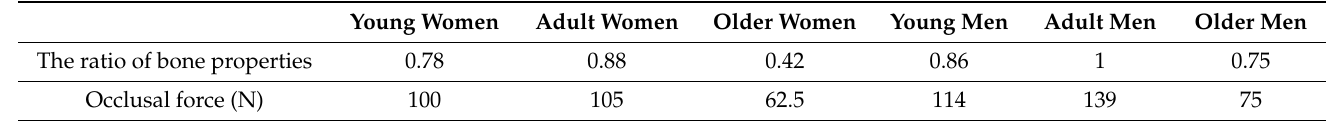
Table 1. The bone properties and occlusal forces used in the current study.